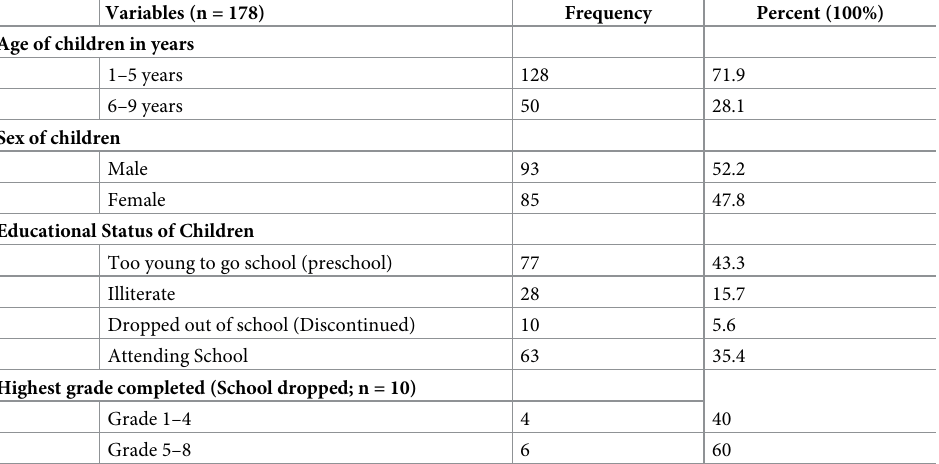
Table 4. Basic characteristics of studied children of Arsi Negele Town, West Arsi Zone, Oromia, Southern Ethio- pia, and December, 2019.